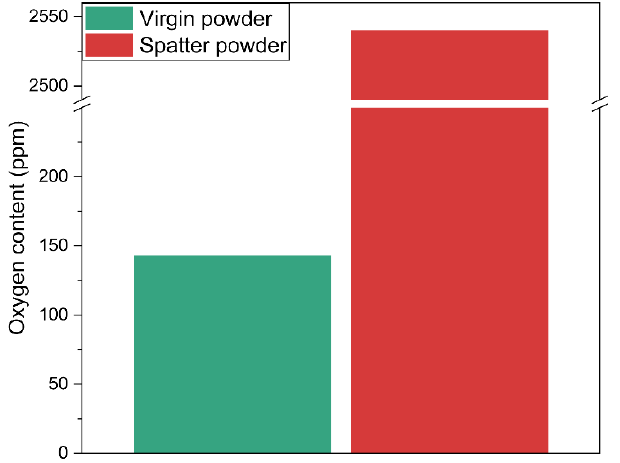
Figure 6. A comparison of oxygen contents of virgin powder and spatter collected from heat shield.